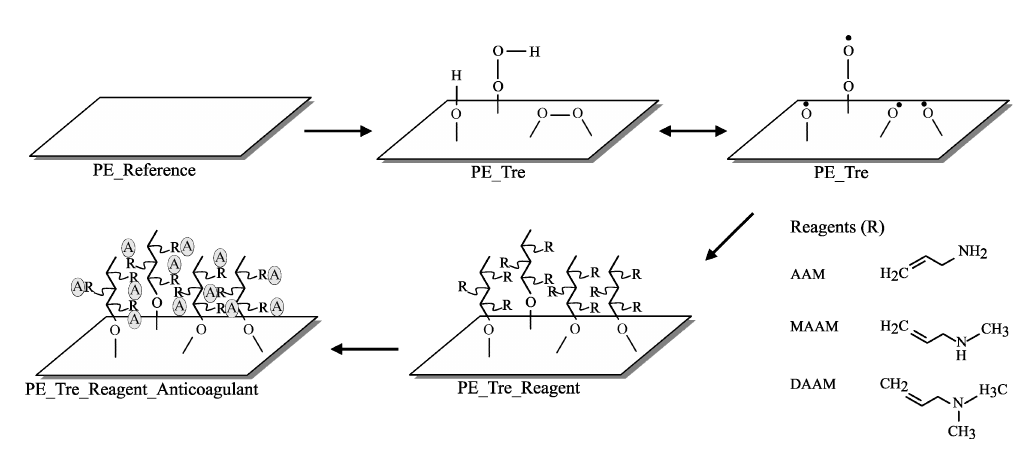
Figure 5. The schematic representation of the process. R stands for grafted Allylamine (AAM), N -allylmethylamine (MAAM), and N , N -dimethylallylamine (DAAM) and A stands for anticoagulants of heparin and fucoidan.